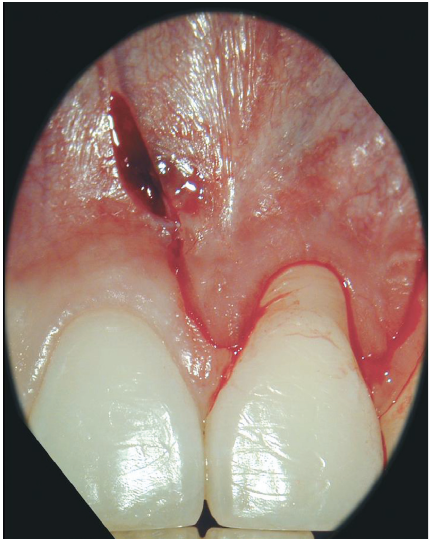
Figure 2: Trapezoidal flap was prepared. The vertical incisions extended significantly beyond the mucogingival junction and were